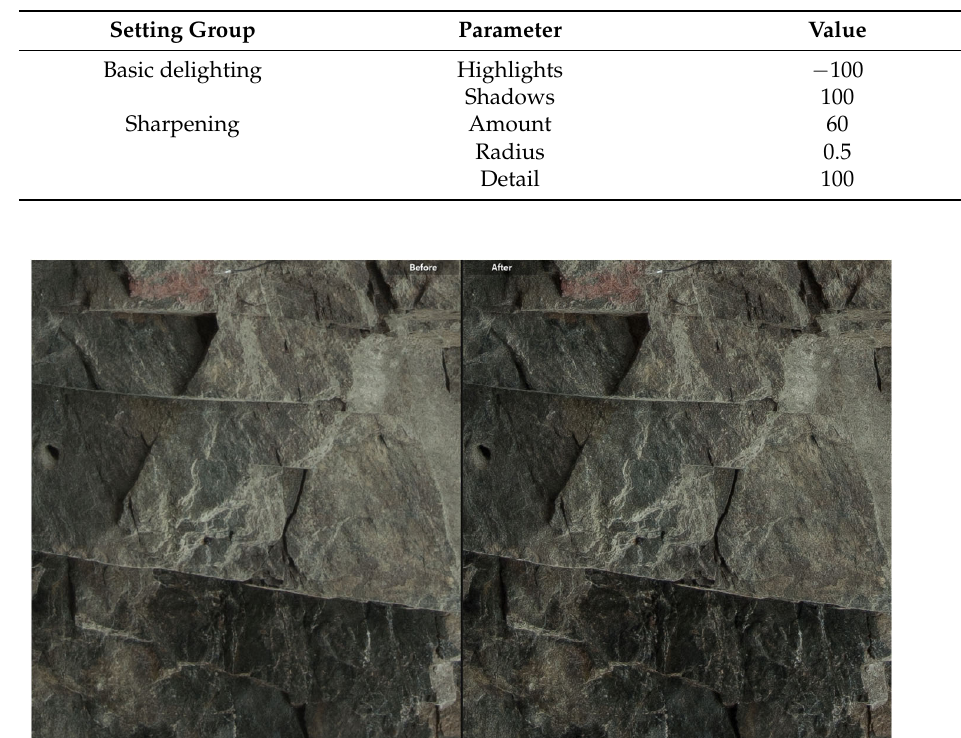
Figure 4. Planned image network with 27 locations of the 360 ‐ degree camera at the test site of the Underground Research Laboratory of Aalto University ( a ), and the raw image from one of the six lenses in the 360 ‐ degree camera ( b ). Table 1. Image processing settings in Adobe Lightroom Classic.